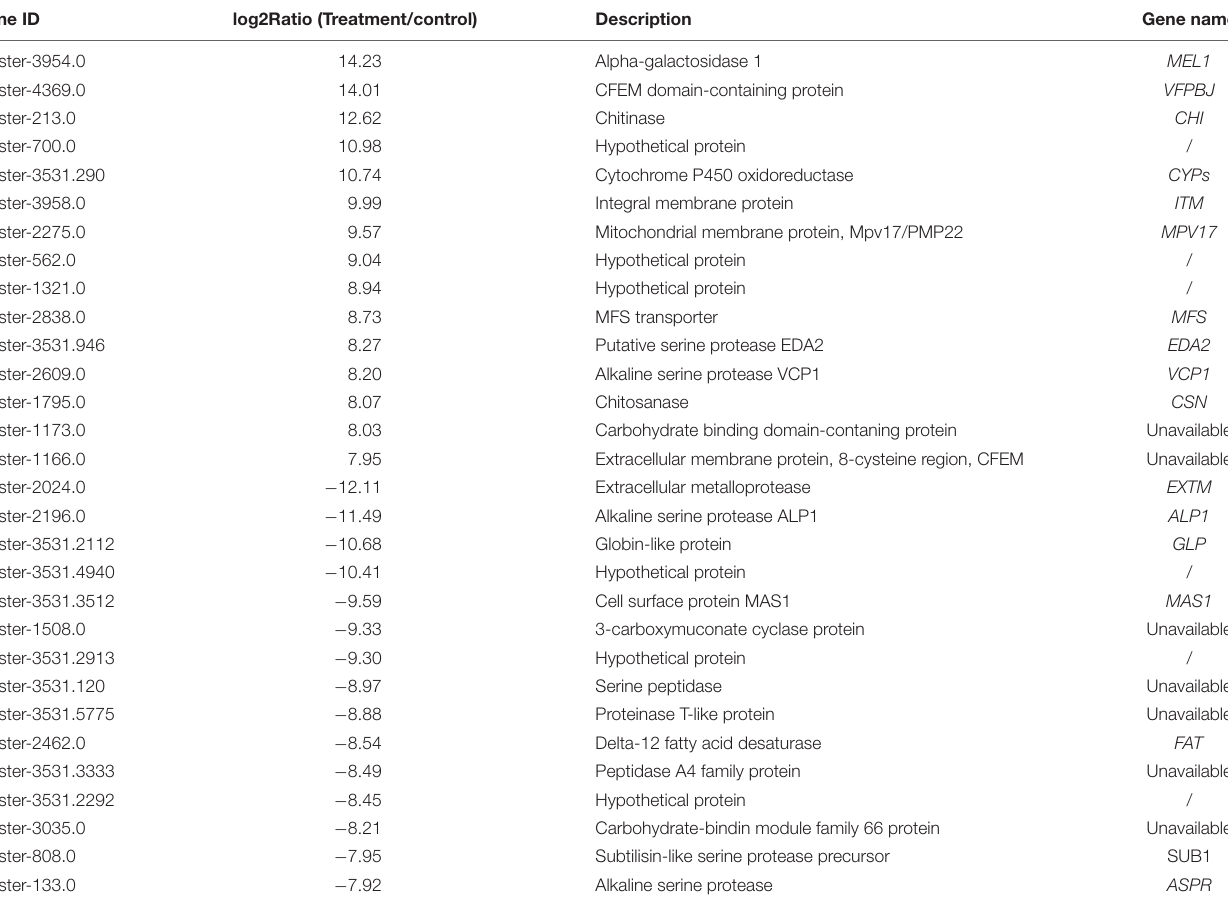
TABLE 3 | Top 15 up- and down-regulated genes in treatment groups compared to the controls, along with corresponding log2Ratios. The significance determination was set as 0.01 p -values (Wald test) corrected by the Benjamini–Hochberg method by using the DESeq